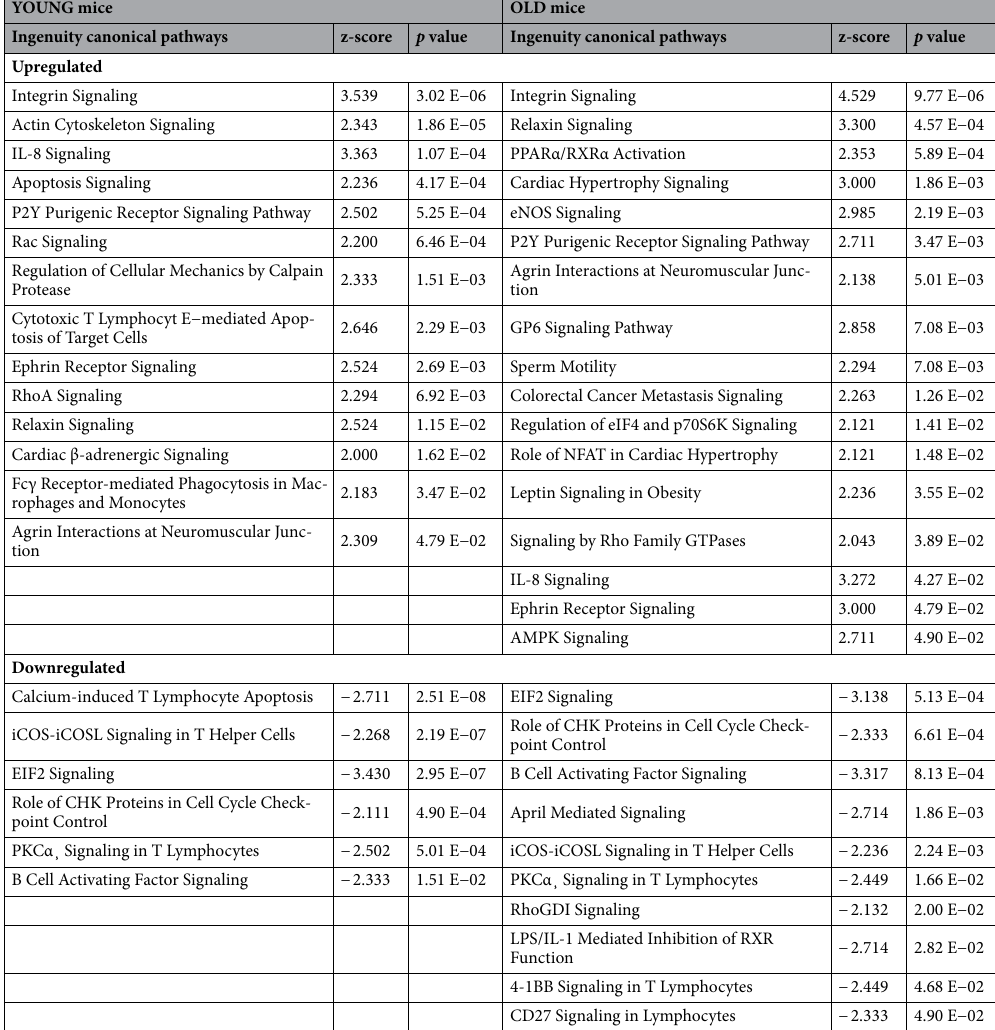
Table 2. Significant canonical pathways among genes differentially expressed in irradiated old and young male mice as identified by Ingenuity Pathway Analysis. Pathways displaying a z-score greater than 2 or lower than -2 and showing Benjamini-corrected p value < 0.05 were considered significant. Canonical pathways are ordered according to their p